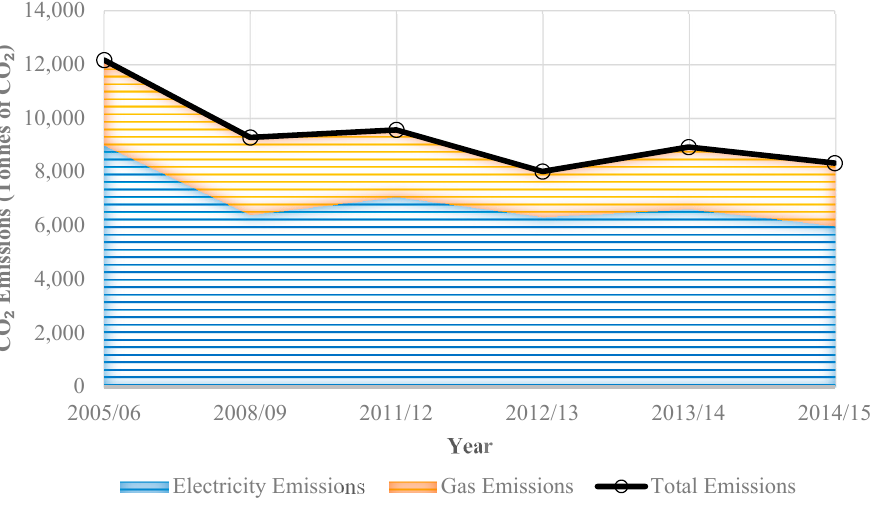
Figure 4. Variation of annual CO 2 Emissions of LSBU [4].